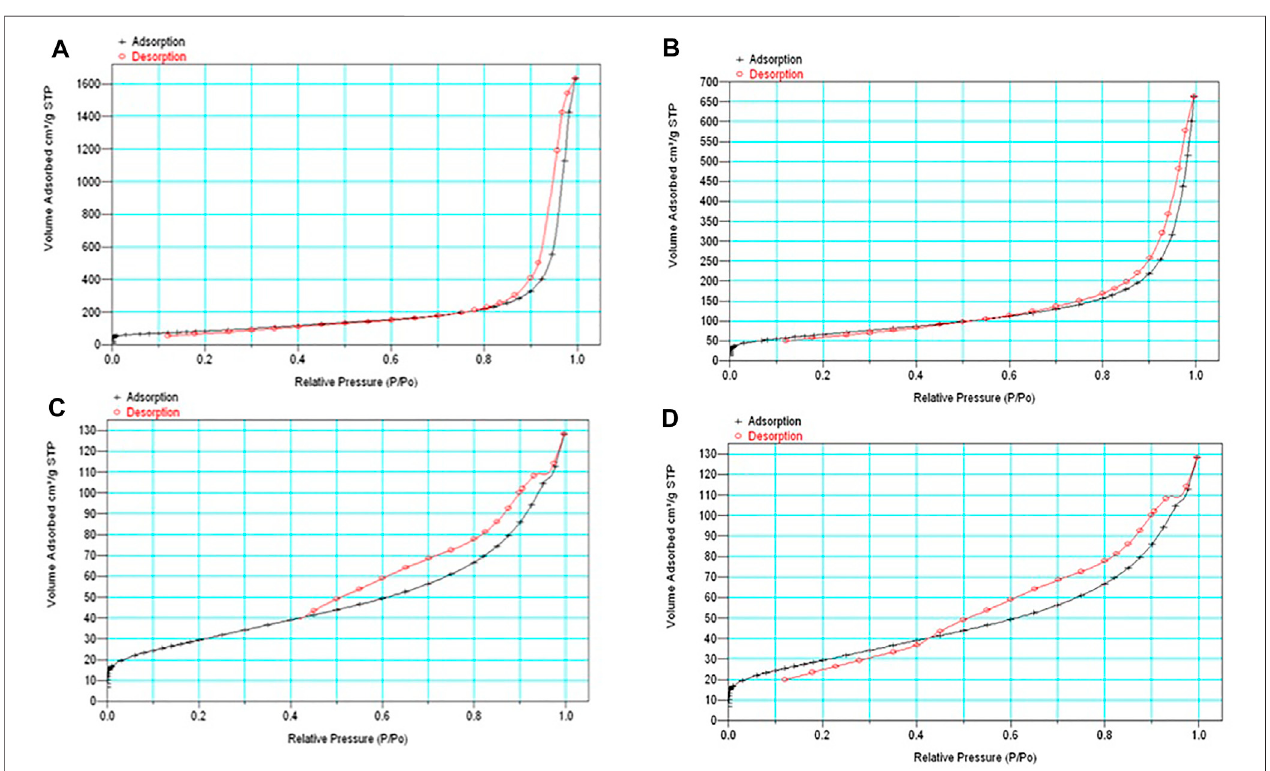
FIGURE 7 | N 2 adsorption – desorption isotherms: (A) fCNT, (B) fCNT/TiO 2 .ZrO 2 (36)500 ° C.20, (C) fCNT/TiO 2 (36)500 ° C.20, and (D) fCNT/ZrO 2 (36)500 ° C.20.